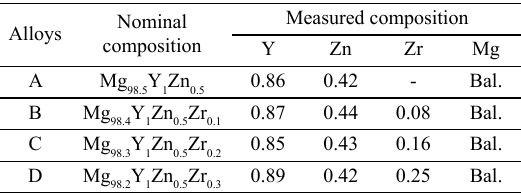
Table 1. The chemical composition of the as-cast alloy (at. %). Nominal Alloys composition